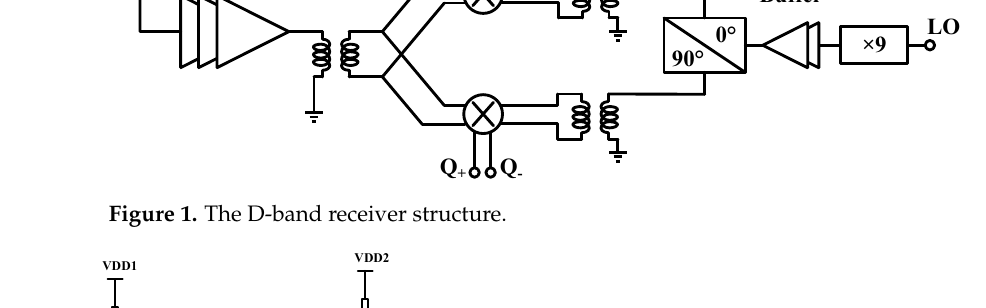
Figure 1. The D-band receiver structure.